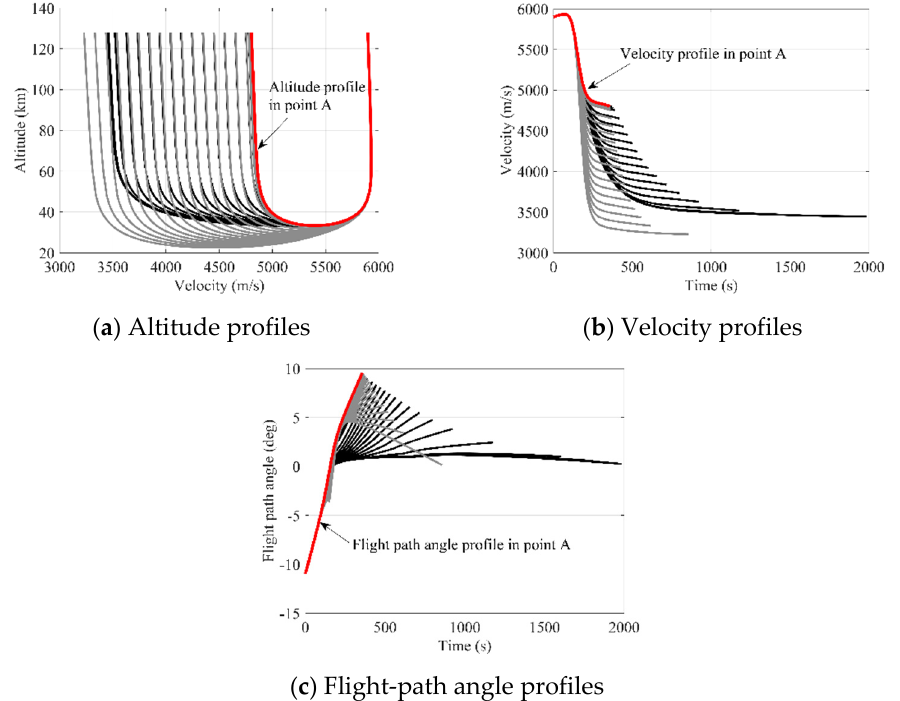
Figure 8. Aerocapture attainability sets described by state variables and orbital elements.